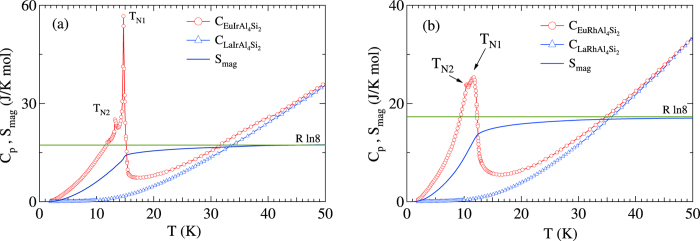
Heat capacity Cp and entropy Smag as a function of temperature in EuTAl4Si2 and nonmagnetic LaTAl4Si2 for (a) T = Ir and (b) Rh. The horizontal line depicts the high temperature limit (R In 8) of the magnetic entropy for an S = 7/2 spin system.